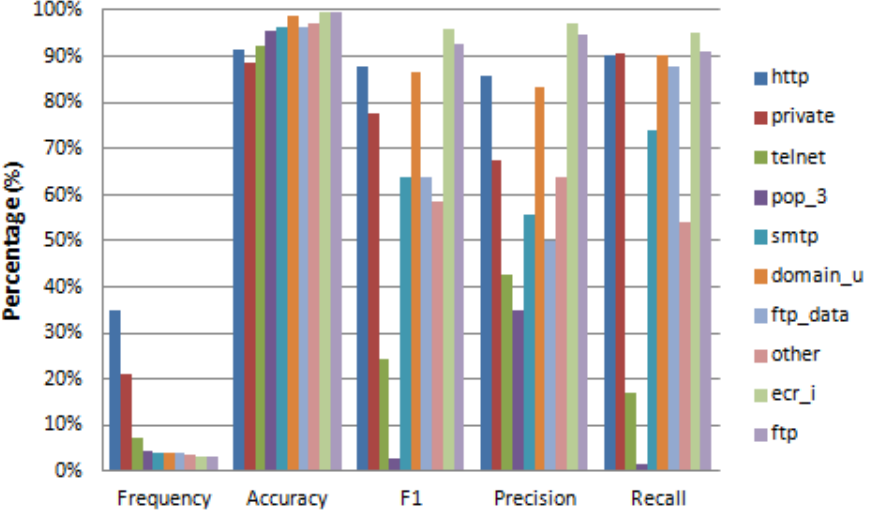
Figure 11. Performance metrics (One vs. Rest) for reconstruction of all features values when feature: ‘ service ’ is missing.